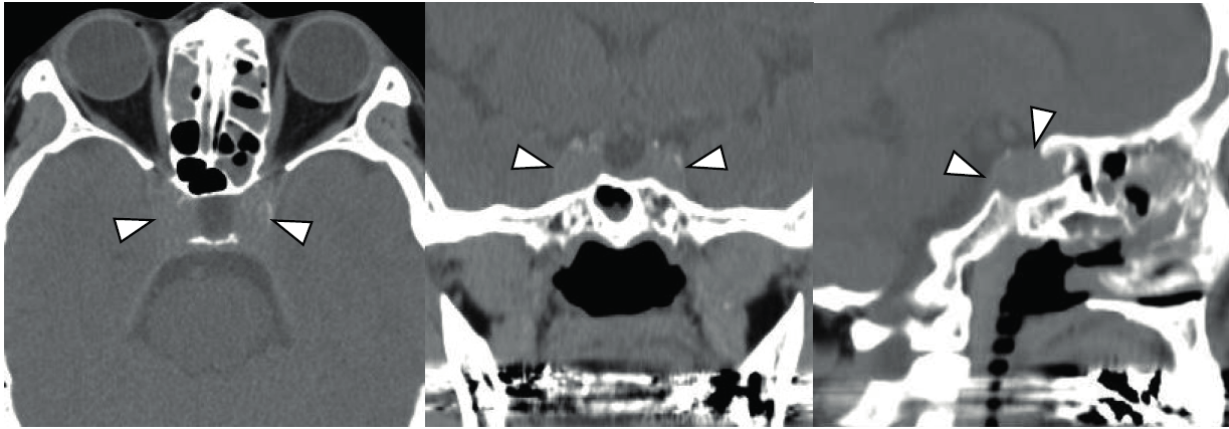
Figure 4. Preoperative computed tomography without contrast enhancement of the cavernous sinus. Arrowheads show the contour of the cavernous carotid aneurysm. The aneurysm is detectable in a soft tissue window of the coronal and sagittal planes but is difficult to detect in the axial